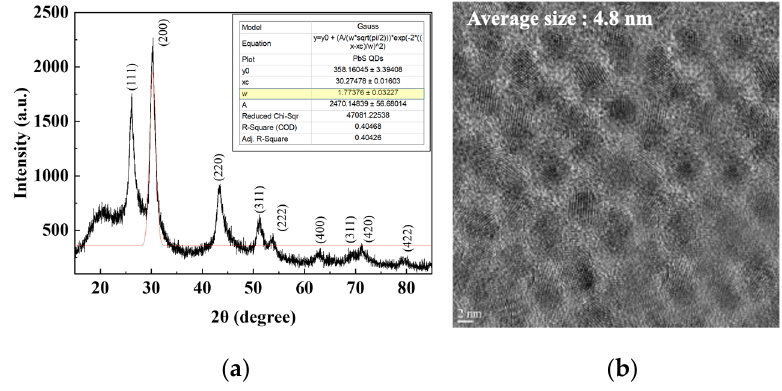
Figure 3. ( a ) XRD analysis and ( b ) TEM image of the synthesized PbS